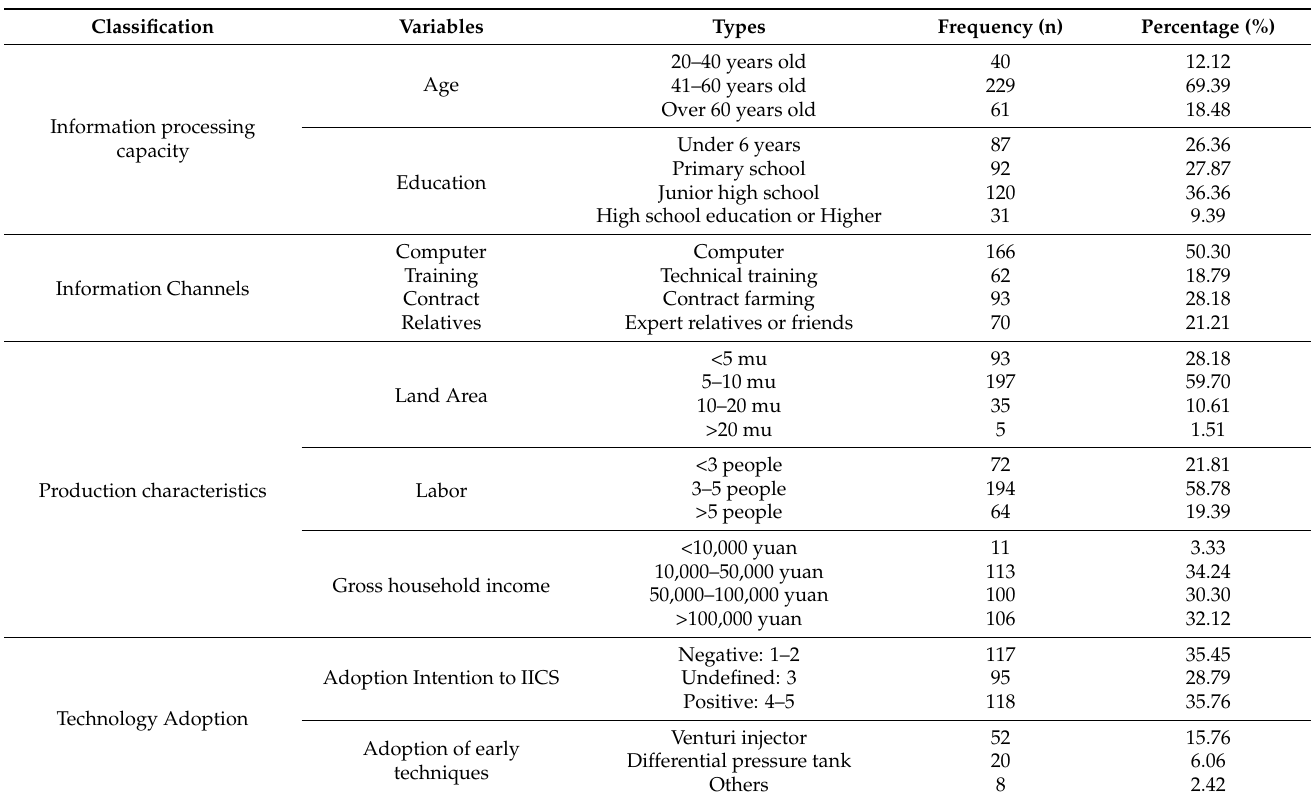
Table 1. Descriptive statistics of